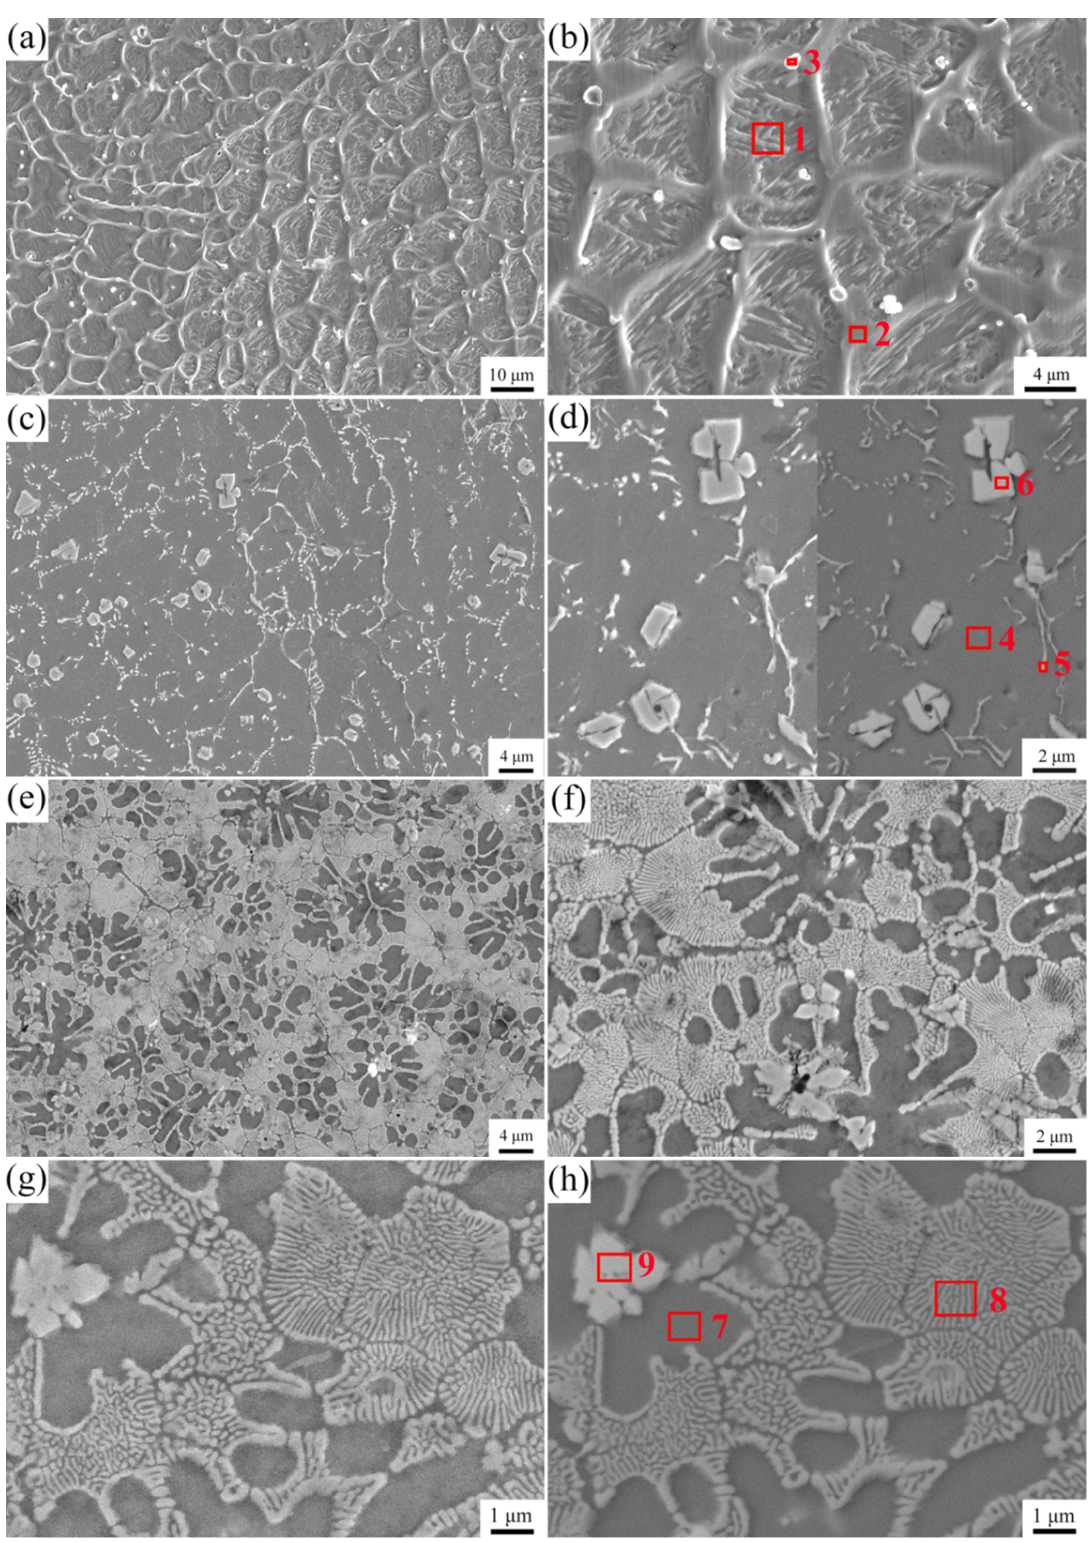
Figure 3. ( a , b ) SE (Secondary electron) images of Coating I; ( c ) SE image of Coating II; ( d ) SE image (left) and BSE (Back-scattered electrons) image (right) of Coating II; ( e – g ) SE images of Coating III; ( h ) BSE image of Coating III.